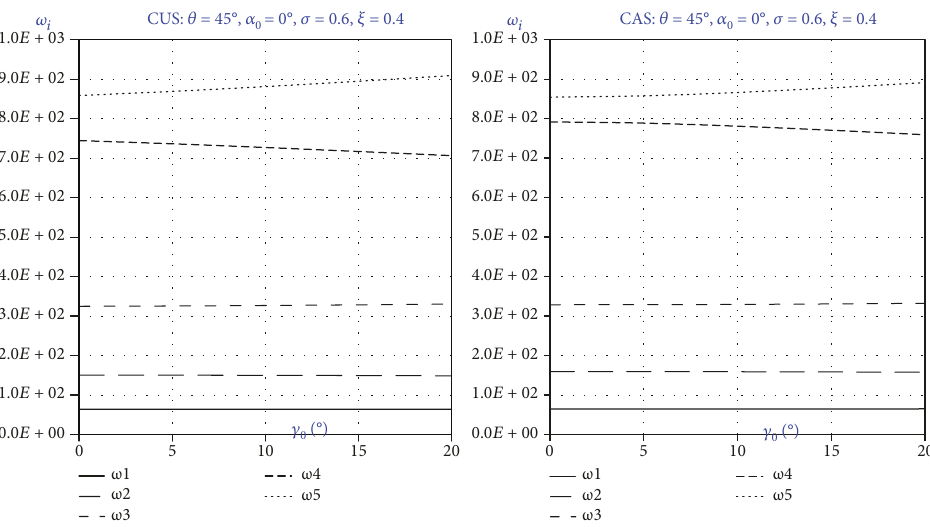
= 0 for CUS and 0